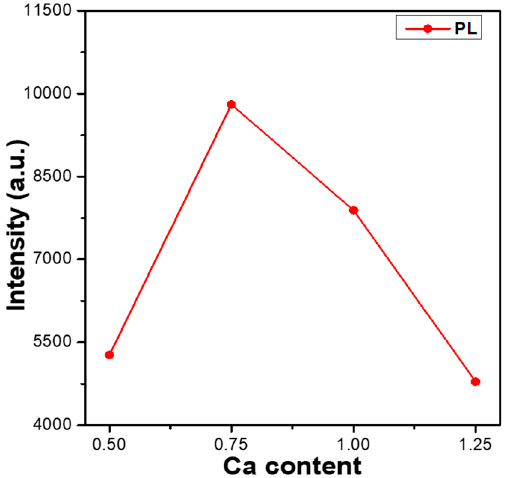
Figure 5. Variation in the PLmax values of Ca x Mg 2-x Si 2 O 6 :0.025Eu 2+ phosphors as a function of the Ca content.